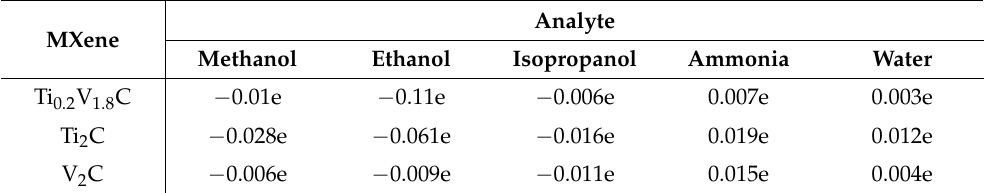
Table 1. Mulliken charges, e, characterizing the interaction of analyte molecules with MXene surfaces.